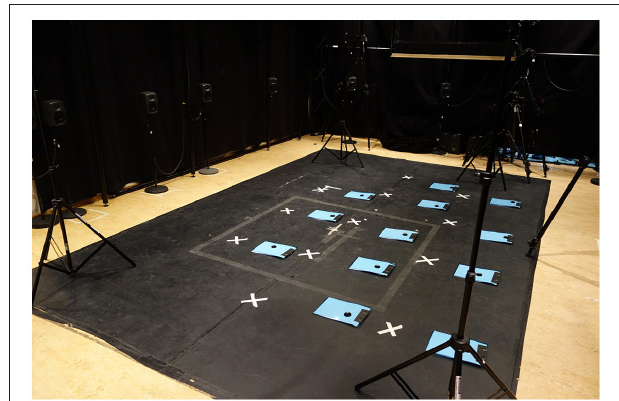
FIGURE 2 | The setup for the experiment in the motion capture laboratory. White marks and questionnaires indicate the position of each participant. Poles with reference markers where placed in each corner of the capture space and used to check the noise-level of the recording (see Jensenius et al., 2012 for a description of the noise-level in optical motion capture